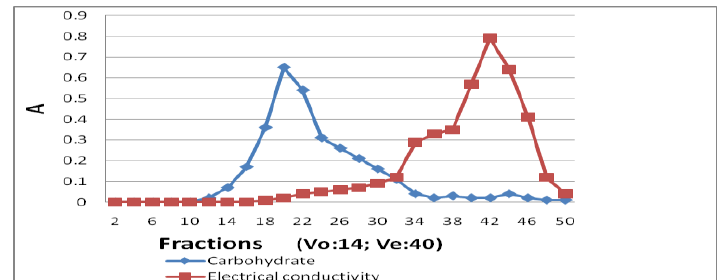
Figure 2. Purification of ITG on Sephadex G-50 column.